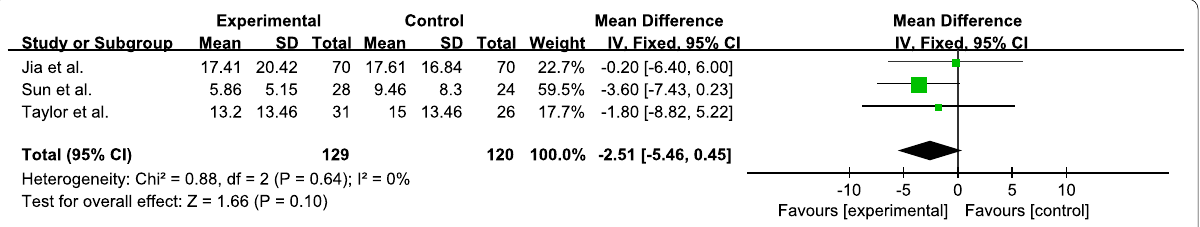
Fig. 5 Forest plot of the ESR by day 7–10 between the experimental group and the control